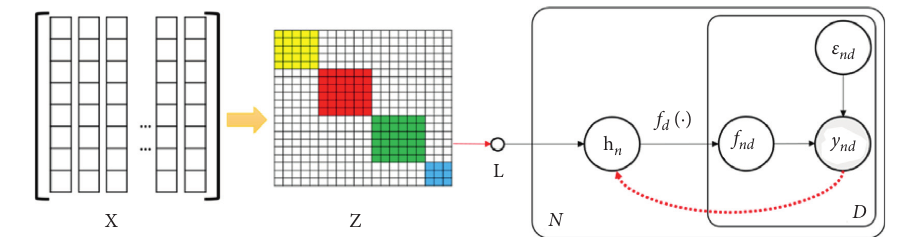
Figure 1: The structure of